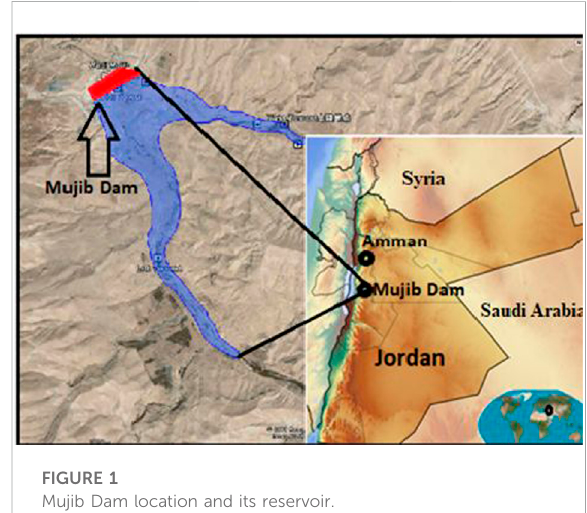
FIGURE 1 Mujib Dam location and its reservoir.